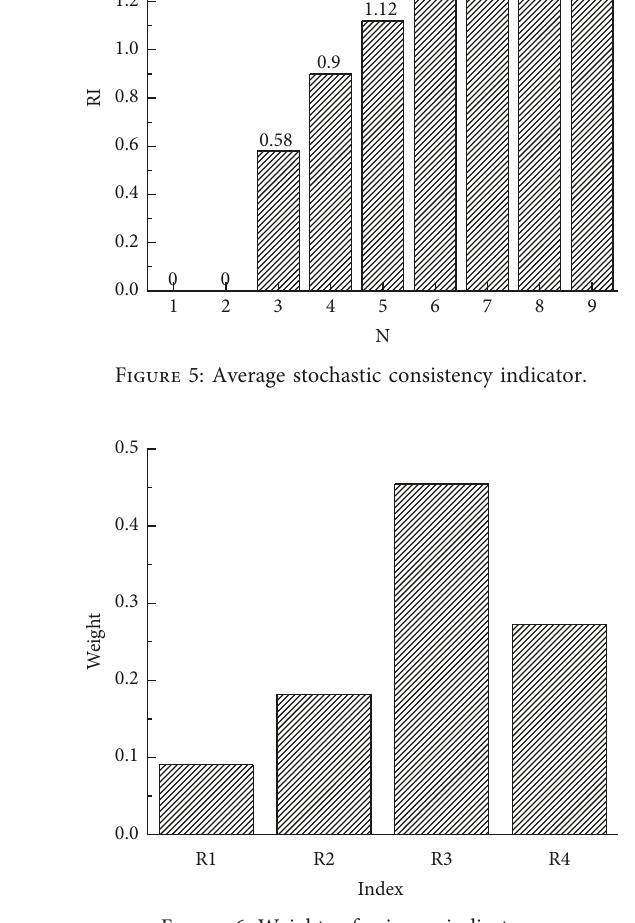
Figure 6: Weights of primary